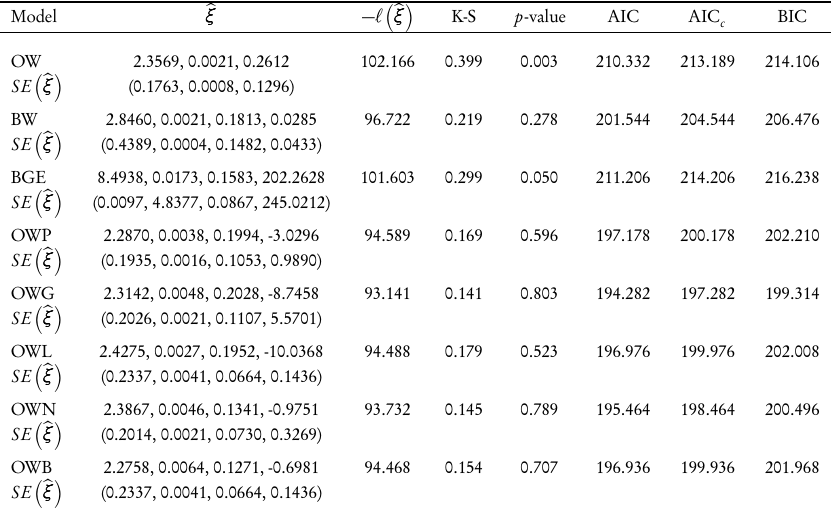
Estimates and goodness-of-fit measures for the second data set.